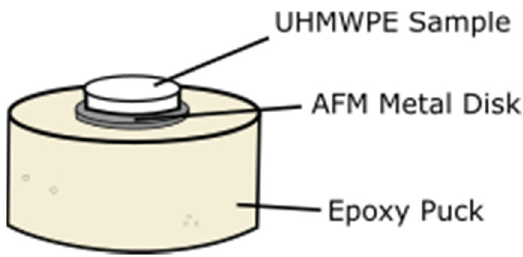
Figure 3. UHMWPE sample setup used for surface polishing and cleaning